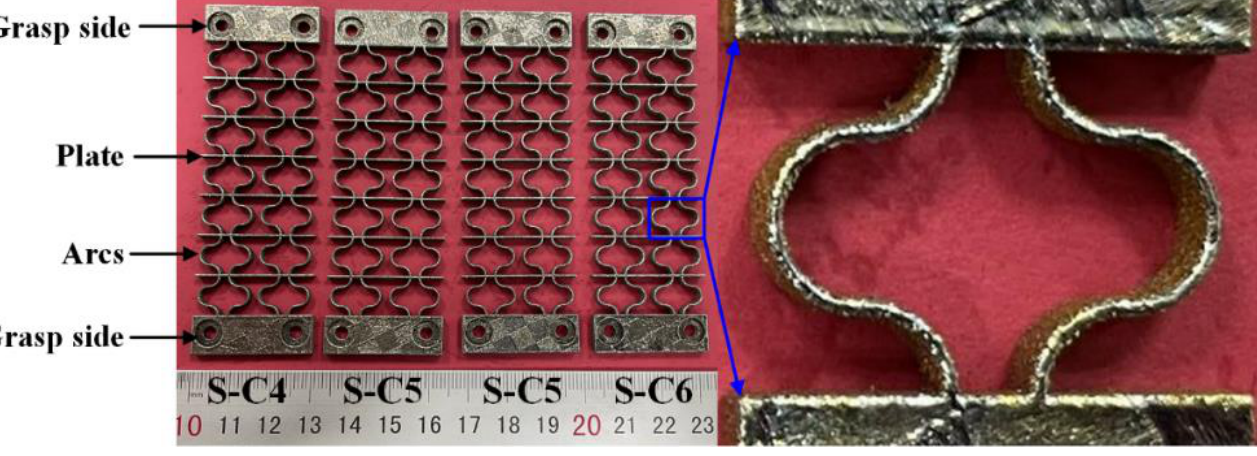
Figure 6. SLM – fabricated active SMA honeycomb arrays.